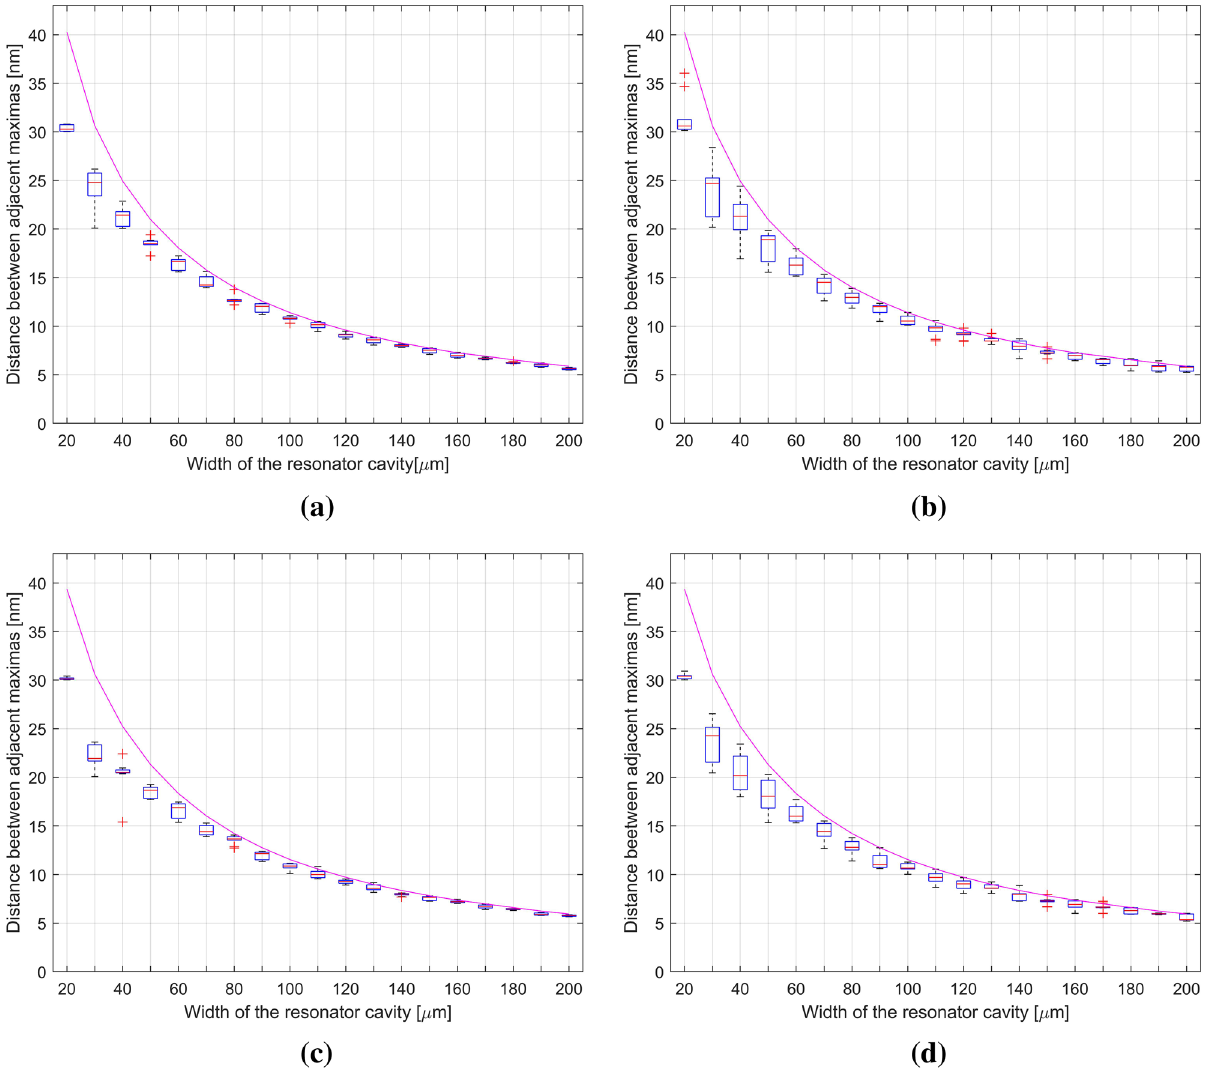
Figure 8. Distance between adjacent maxima in the signal using a 1550 nm source: ( a ) measured between the central and left peaks for silver mirror; ( b ) measured between the central and left peaks for SiN thin film; ( c ) measured between the central and right peaks for silver mirror; ( d ) measured between the central and right peaks for SiN thin film (where the magenta line is a theoretical model of data, red horizontal line is the mean value, red crosses are outliers).